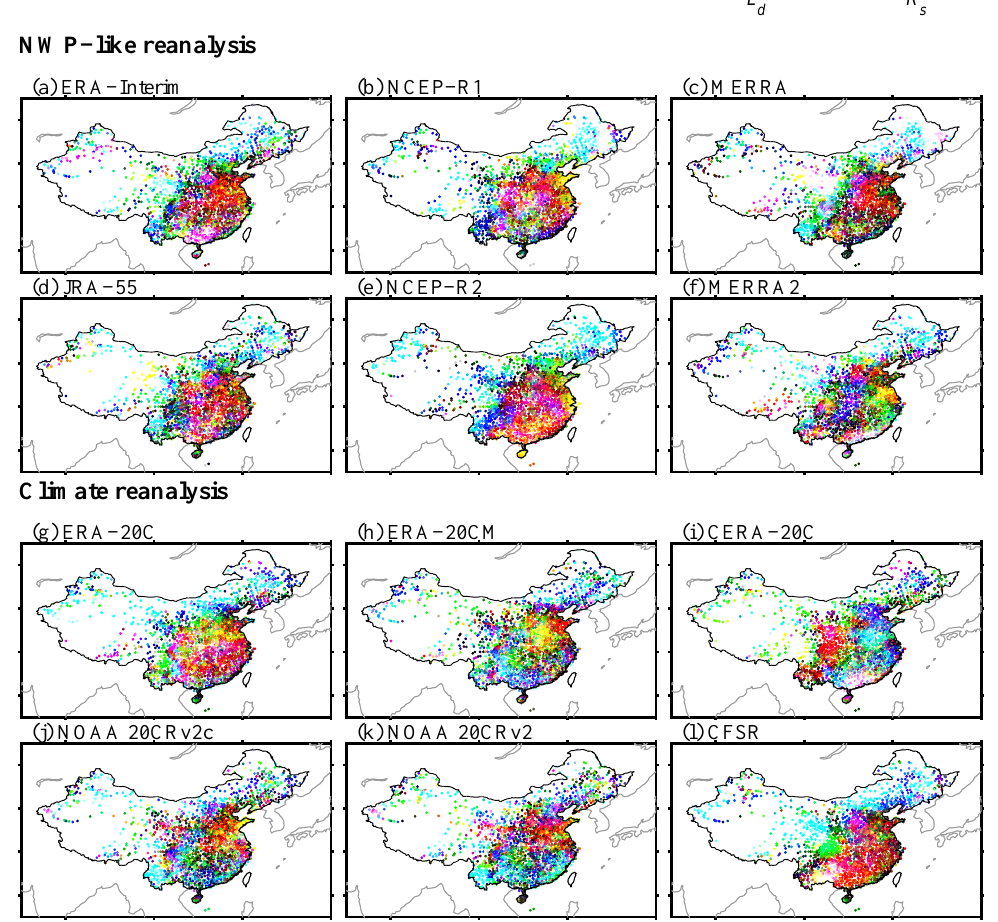
Figure 6. Composite map of the contributions (unit: ◦ Cdecade − 1 ) of the biases in the trends in three relevant parameters, surface incident solar radiation ( R s , in red), surface downward longwave radiation ( L d , in green) and precipitation frequency (in blue) to the biases in the trends in surface air temperature ( T a ) during the study period of 1979–2010, as estimated using the 12 reanalysis products over